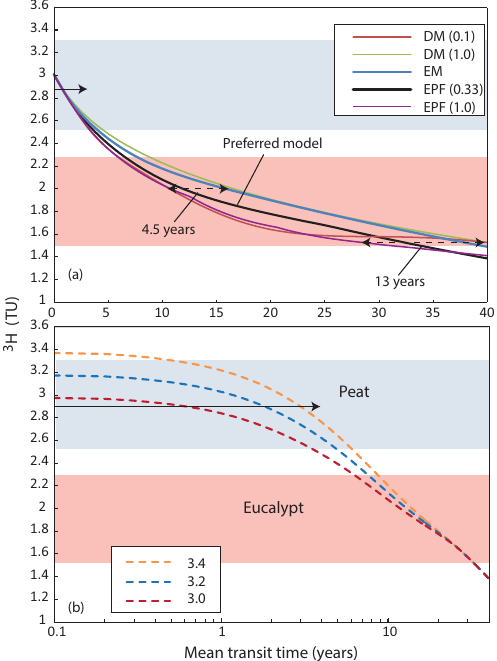
11.21.41.61.822.22.42.62.833.23.43.6 0.1 Figure 6. Comparison of mean transit times from different lumped parameter models calculated using Eqs. (1) to (3) assuming a 3 H activity of recharge of 3.0 TU (based on the rainfall samples). DM indicates dispersion model with D P values of 0.1 and 1.0; EM in- dicates exponential flow model; EPF indicates exponential-piston flow model with EPM ratios of 0.33 and 1.0. (b) Mean transit times from the exponential flow model (EPM ratio of 0.33) with 3 H ac- tivities of modern recharge ranging from 3.0 to 3.4 TU. Shaded fields show 3 H activities in the peatland waters and eucalyptus for- est streams; arrow is the median 3 H activity in the peatland waters (data from Table